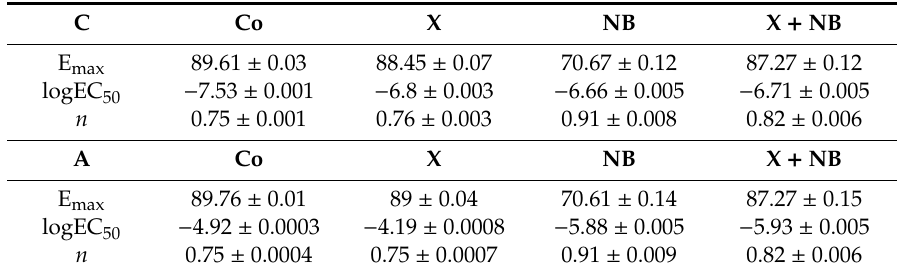
Table 2. The Hill parameters of the concentration-response (E / c) curves that were simulated according to the Model 4 and are presented in Figure